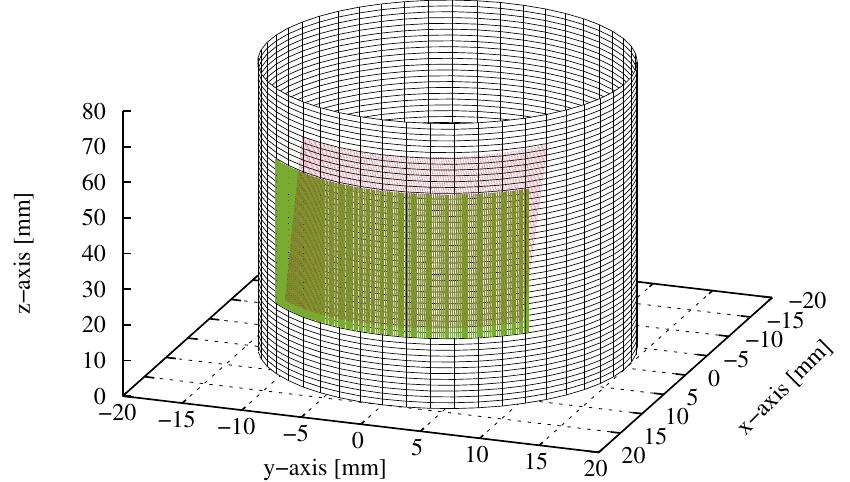
Figure 1. Tension–torsion example (smooth surface): generated (pattern) points on the surface in the reference (green) and calculated positions in the current configuration (dark